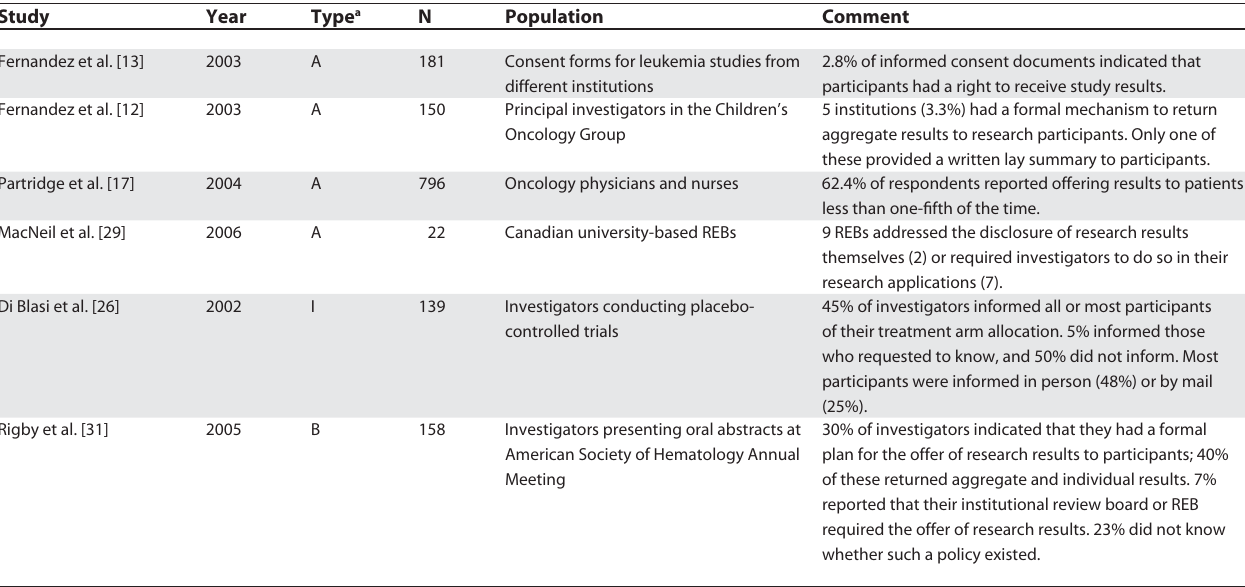
Table 3. Research Results Communication Practices